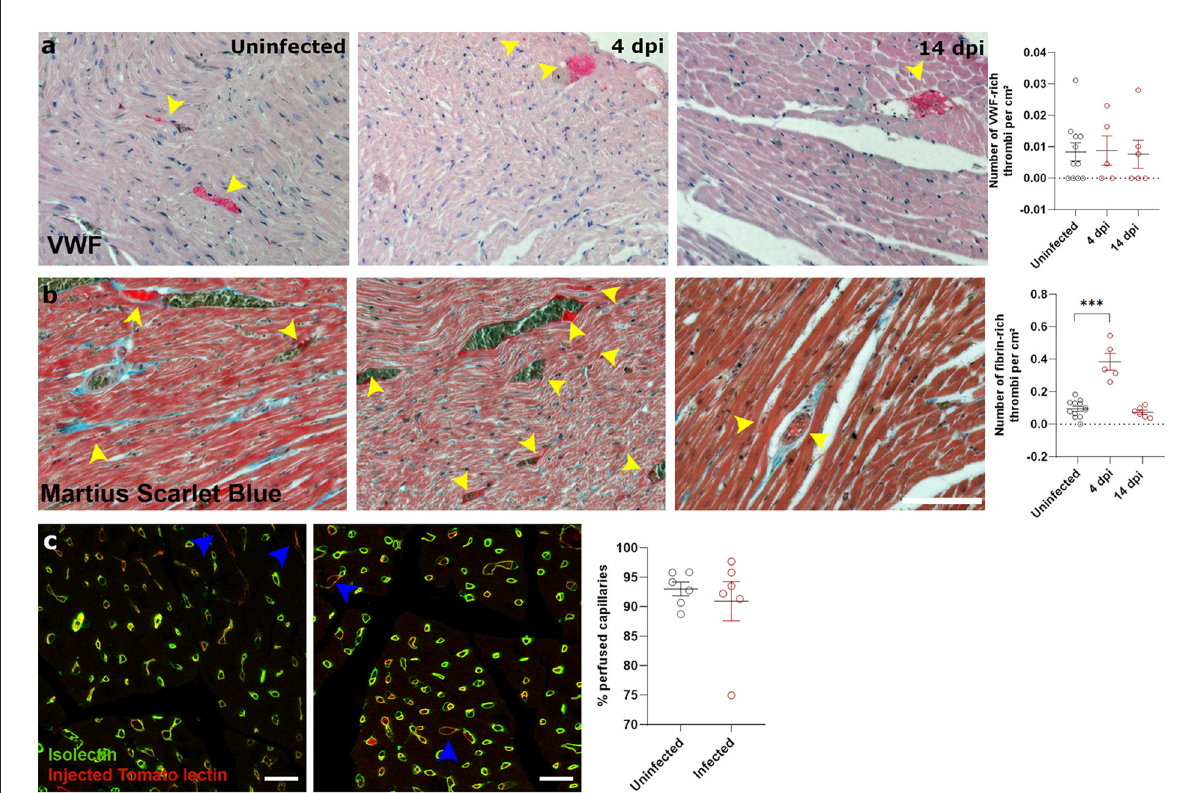
FIGURE3 SARS-CoV-2 infected hamsters have transient fibrin-rich thrombi, while perfusion is not affected. (a,b) Twelve week old hamsters were infected with SARS-CoV-2 virus and sacrificed at 4 and 14 dpi. Left ventricle heart sections were stained for VWF (a) or Martius Scarlet blue (b) to analyse the number of VWF-rich and fibrin-rich thrombi, respectively. Yellow arrowheads indicate thrombi. Values are presented as mean ± SEM with n = 12 (uninfected) and 5-6 (SARS-CoV-2 infected hamsters). Statistical analysis was performed using a one-way ANOVA followed by a Dunnett’s multiple comparison test with *** p < 0.001 comparing 4 dpi and 14 dpi hamsters to age-matched uninfected hamsters. (c) Hamsters were infected with SARS-CoV-2 virus and at 4 dpi injected with Tomato-Lectin 1min before sacrifice to label perfused capillaries. Left ventricle heart sections were stained for isolectin B4 to analyse obstructed capillaries. Values are presented as mean SEM with n = 6. Statistical analysis was performed using a two-tailed Student’s t